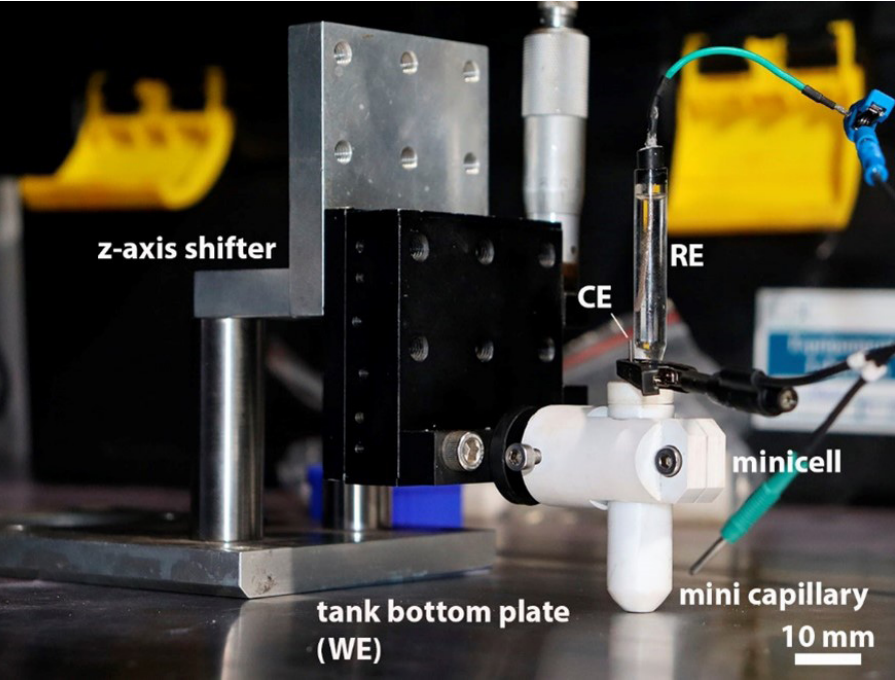
Figure 3. Portable electrochemical minicell using a capillary of 1.5 mm. The working electrode (WE) is the bottom plate that was connected to the potentiostat; reference electrode (RE) is an Ag|AgCl|KCl (3 mol L -1 ) electrode with 5.0 mm diameter; counter electrode (CE) is a titanium rod with a platinum wire involved in a